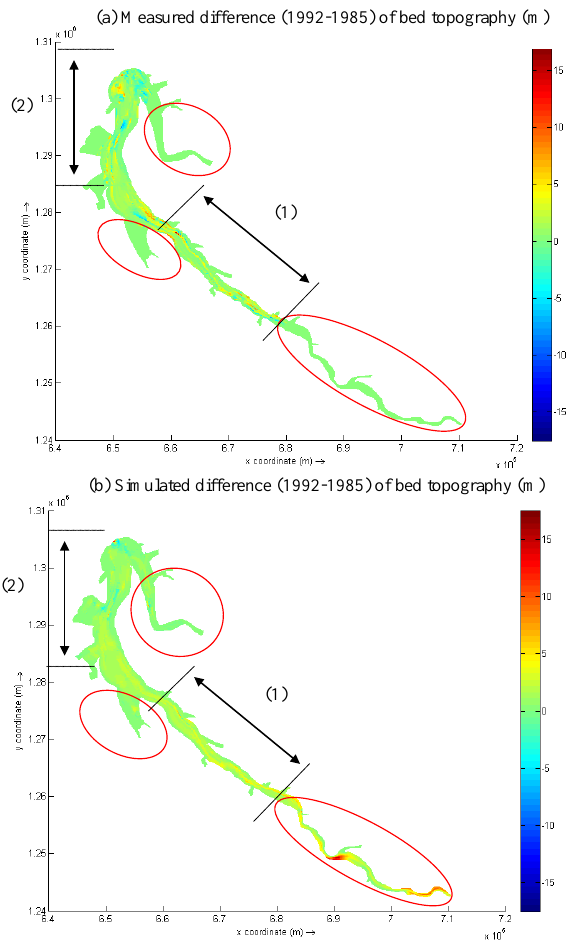
Fig. 9. Comparison between the difference in measured bed topography 1992-1985 Figure 9. Comparison between the difference in measured bed to- and the model cumulative erosion and deposition during the seven-years model run. pography for 1992–1985 and the model cumulative erosion and de- position during the 7-year model run.